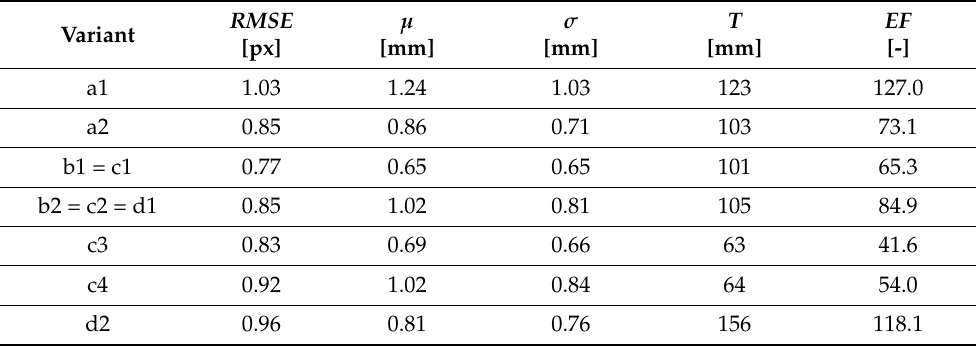
Table 3. The quantitative comparison of the research